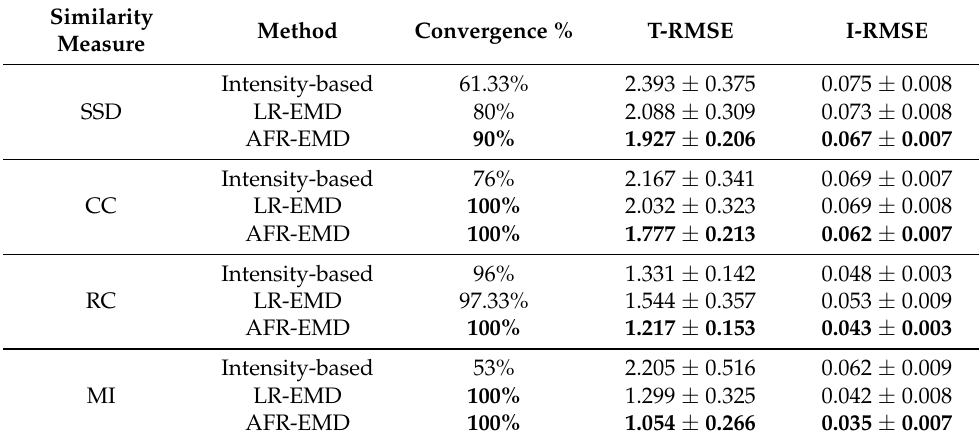
Table 1. Summary of the quantitative performance measures. The measures for the best-performing algorithms are highlighted in bold.